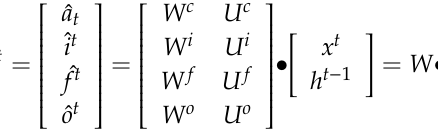
Figure 5. The Gated Recurrent Unit (GRU) algorithm.